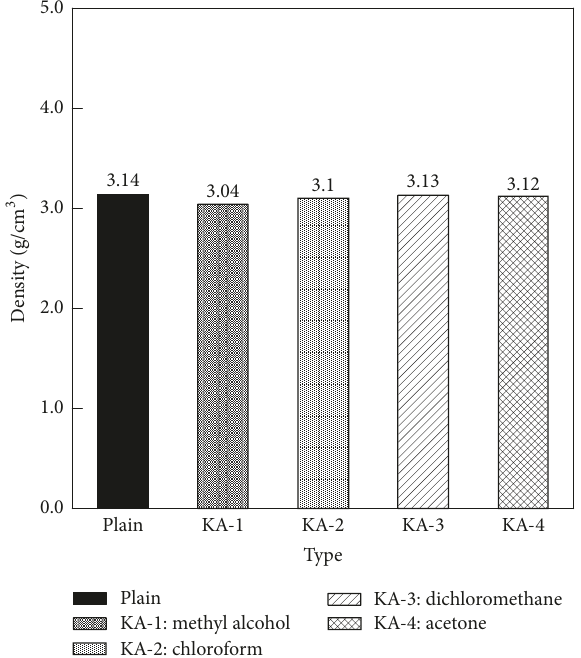
Figure 7: Required amount of KA.